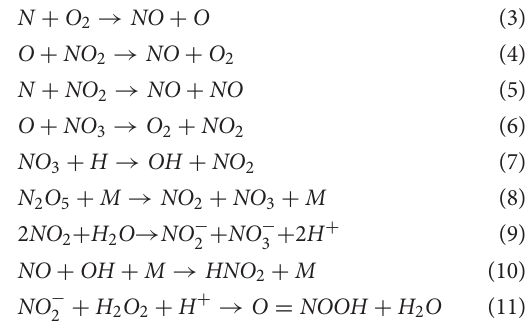
FIGURE 8 | Gas-phase FTIR spectra: (A) NO 2 , (B) NO of varying